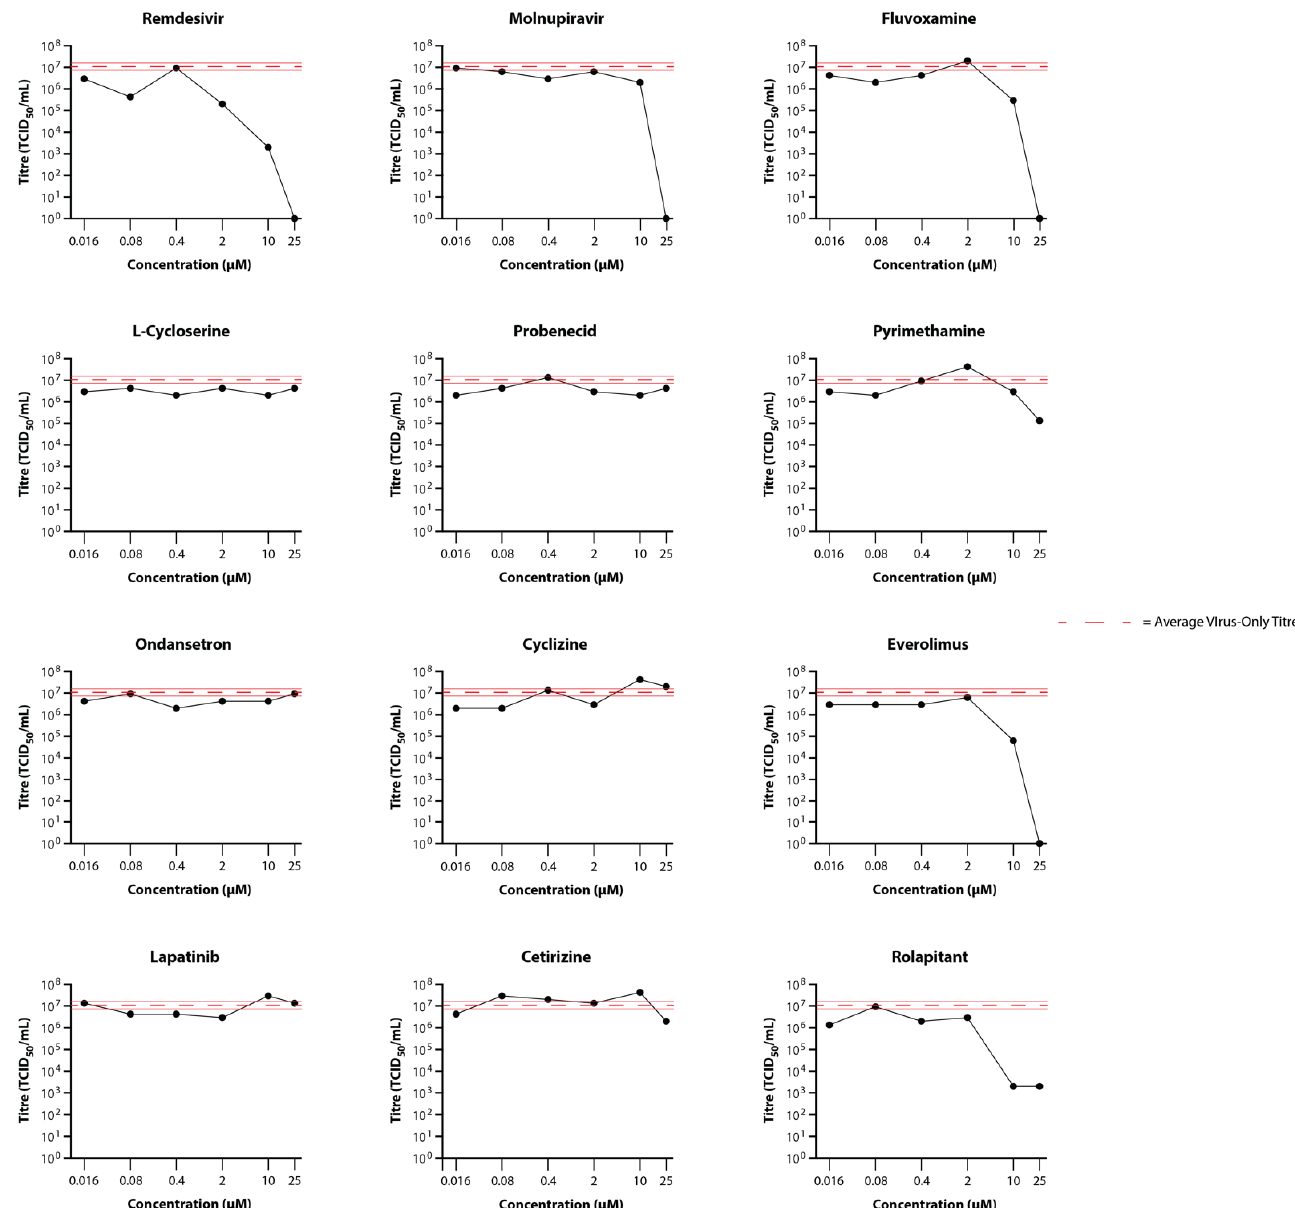
Figure 3. Primary Screening of Selected Drugs on the Growth of SARS-CoV-2 Delta in MatTek EpiAirway Tissue Model. Titres in the EpiAirway tissue model in the presence of 25, 10, 2, 0.4, 0.08, or 0.016 μ M control (Remdesivir and Molnupiravir) or test (Fluvoxamine, L-Cycloserine, Probenecid, Pyrimethamine, Ondansetron, Cyclizine, Everolimus, Lapatinib, Cetrizine, and Rolapitant) drugs were determined by titrating the apical wash samples collected after 48 hr (black dots). The Red dashed line represents the average titre (±SD) from the biological triplicate Delta virus-only control samples.